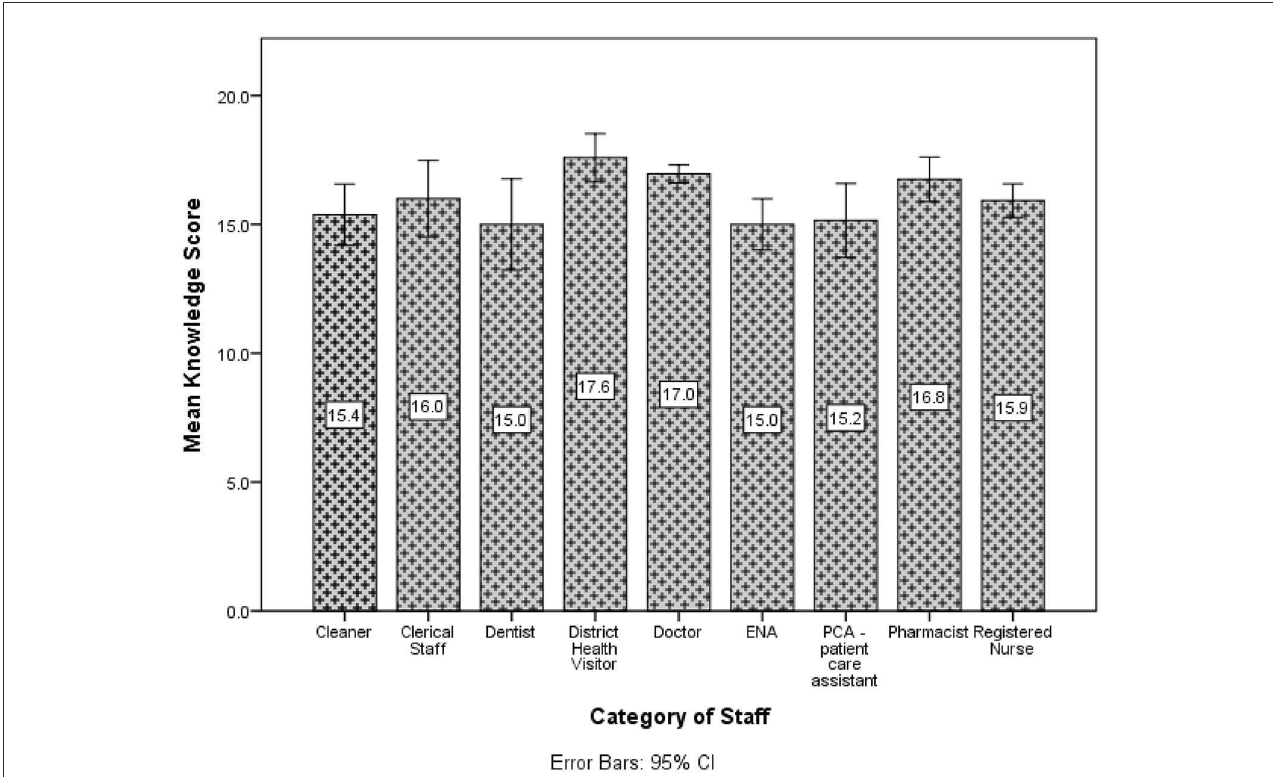
FIGURE2 Participants’ mean knowledge score about the AstraZeneca vaccine by category of